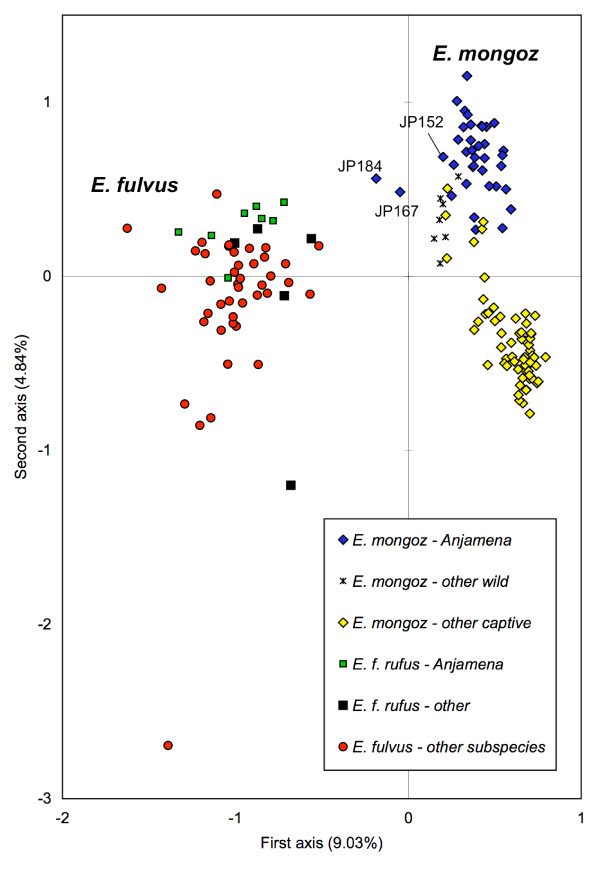
Principal component analysis of individual E. mongoz and E. fulvus genotypes. First and second axes represent the first two factorial components. The two hybrids (JP167 and JP184) are specially marked.